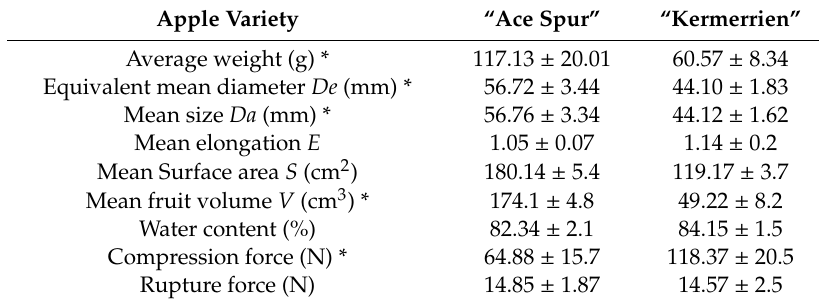
Table 1. Average fruit weight, linear dimensions, size, elongation, and rheological properties of 25 apples taken from “Ace spur” and “Kermerrien” vartieties.